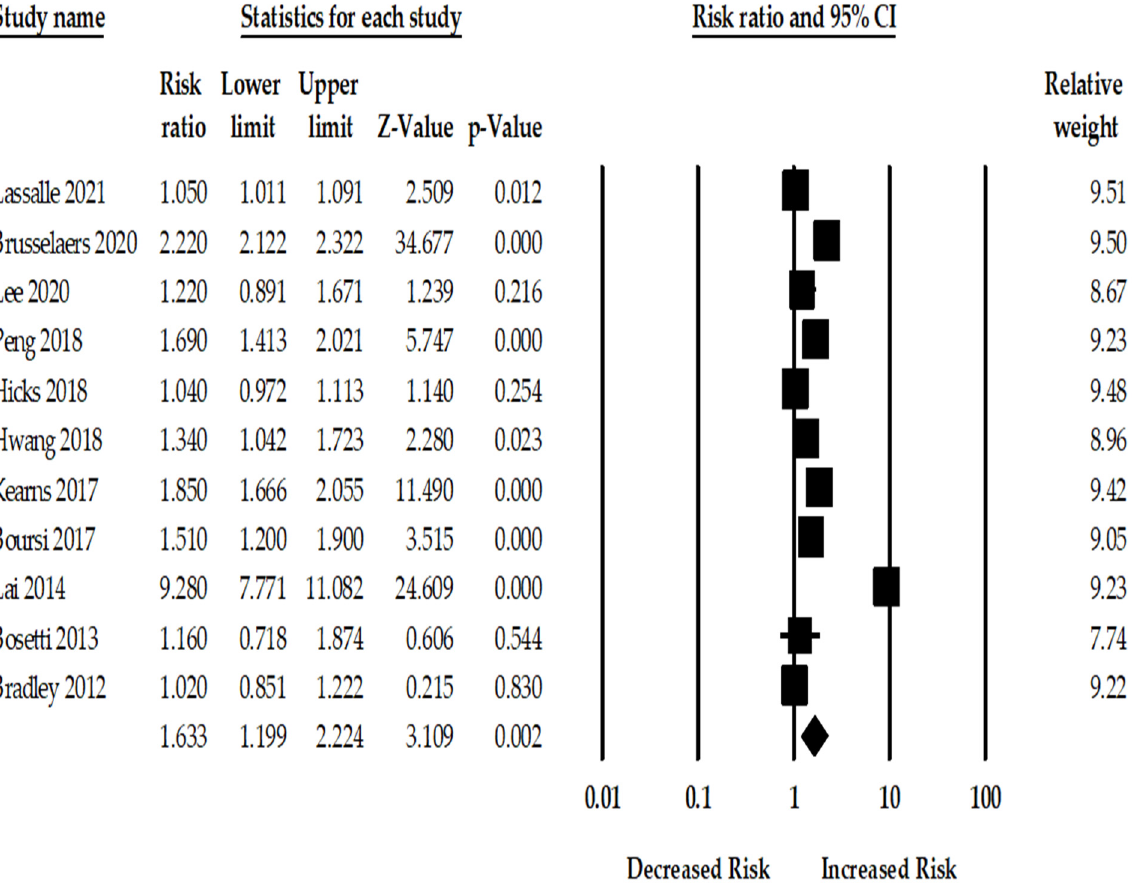
Figure 1. Forest plot of association between PPI and pancreatic cancer risk for eleven studies [12,13,22–30].